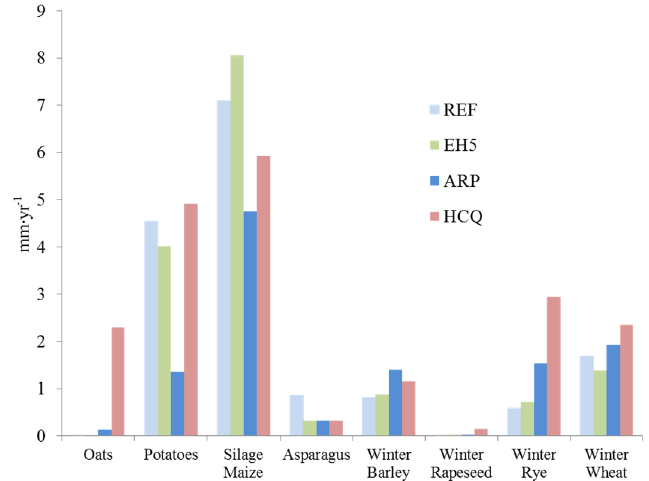
Figure 10. Average irrigation water deficit for several climate projections in dry years (10th percentile) for the period